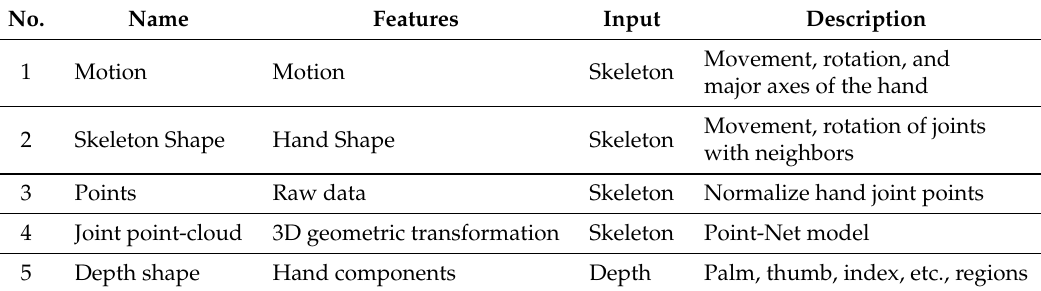
Table 3. List of hand features.